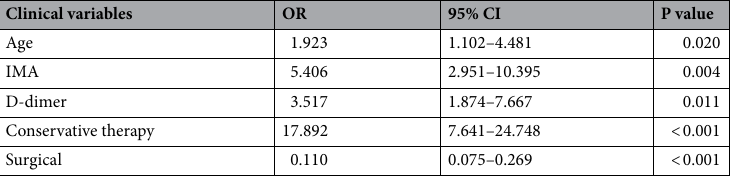
Table 5. Multivariate logistic regression analysis of the different variables associated with in-hospital mortality in TAAD. TAAD, Stanford type A aortic dissection; IMA, ischemic modified albumin; OR, odds ratio; CI, confidence interval.